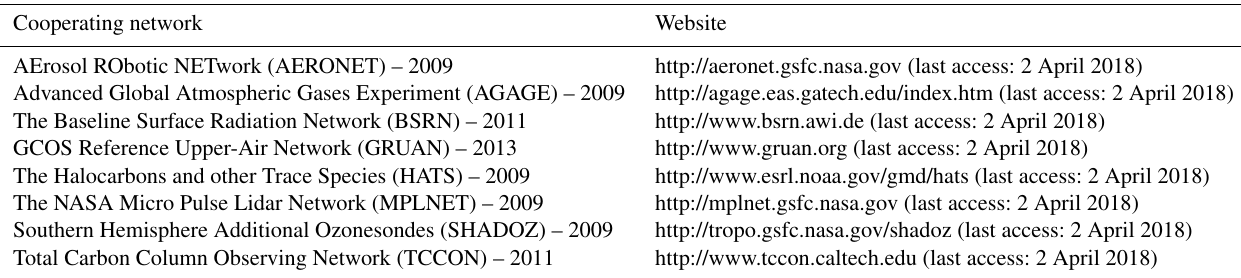
Figure 3. Organizational structure of NDACC and the logo. More details of Steering Committee and working and theme group composition, documents related to group activities, along with the data, are found at the website http://www.ndacc.org (last access: 2 April 2018). Table 2. List of cooperating